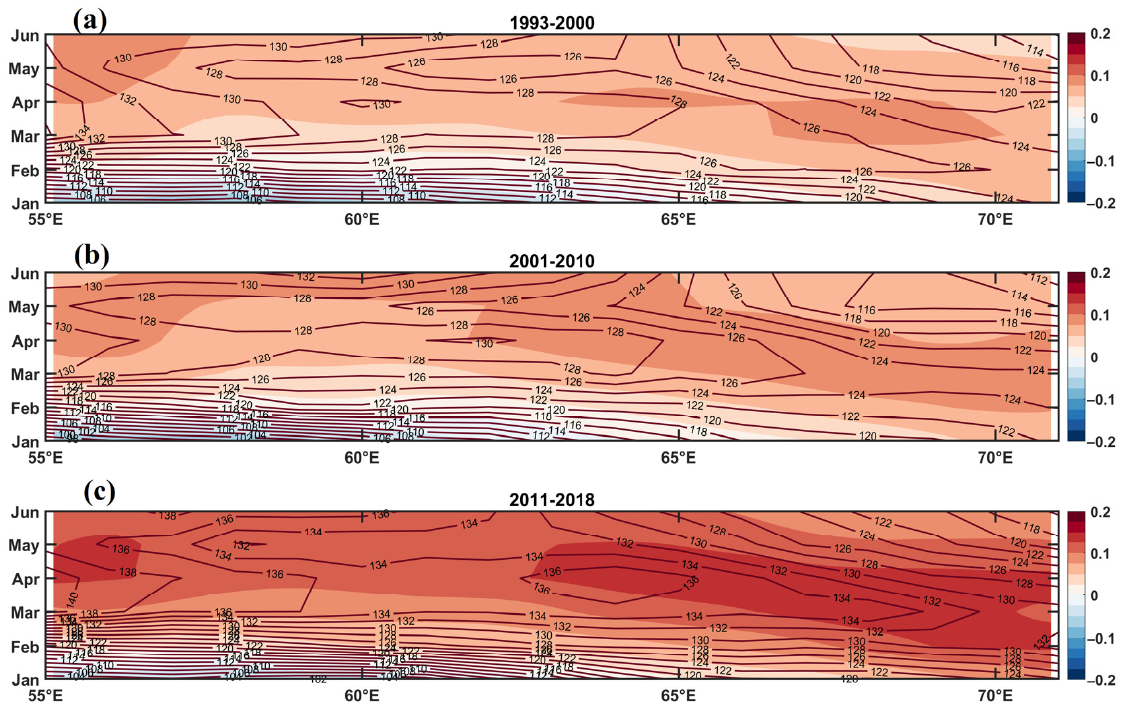
Figure 8. Decadal variation in SSHA representing the propagation of Rossby wave (shaded) along with the D20 contour averaged over the latitudinal band of 2° N–12° N.